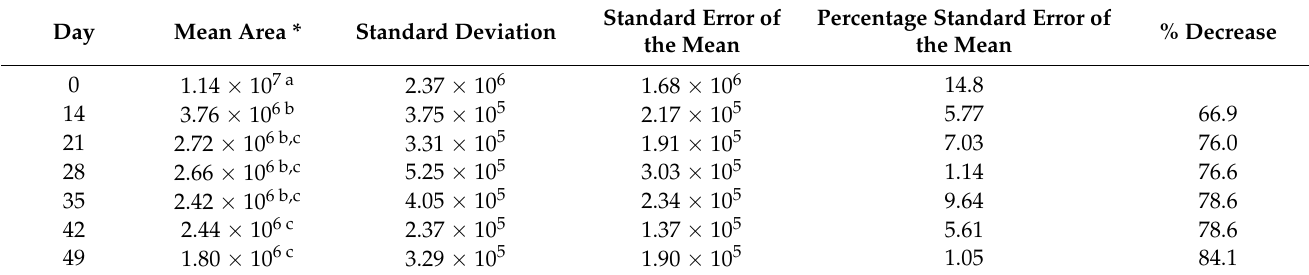
Table 3. Persistence interval of B. perfoliata essential